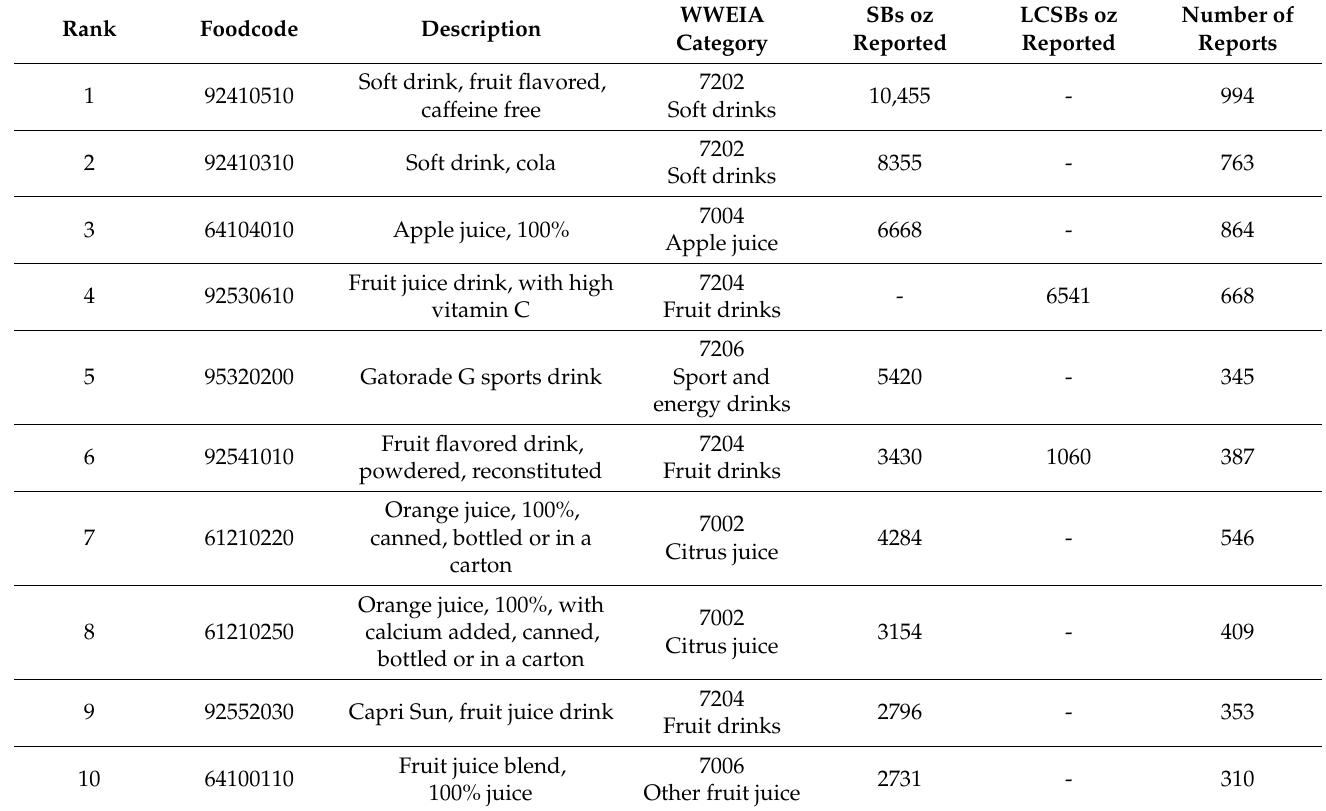
Table 4. Sweetened beverage foodcodes reported to be consumed in the highest quantities by children and adolescents 2–17 years of age in NHANES 2011–2016 when “mixed” codes were considered